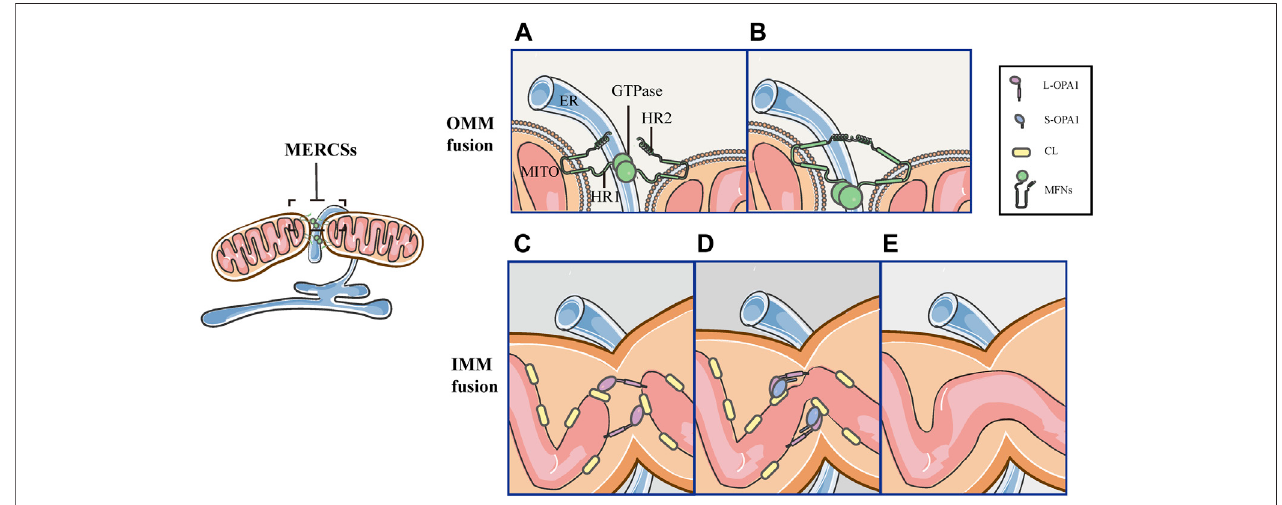
FIGURE6| SchematicdiagramsofmitochondrialfusionatMERCSs.MERCSsde fi nethepositionoftheOMMandIMMfusion,bothofwhicharecoordinatedatthe nodesofMERCSs.Mitochondrialfusionconsistsof fi vedistinctsteps. (A) OMMtethering:MFNstethertheOMMoftwoopposingmitochondriathroughtheirinteractions in trans of the HR2 and/or GTPase domains. (B) OMM docking: GTP hydrolysis induces conformational changes in MFNs, which trigger docking of the OMM. Subsequently, the GTPase-dependent MFNs oligomerization completes fusion of the OMM. (C) L-OPA1-CL tethering: the IMM fusion begins with the interaction betweenL-OPA1andCL. (D,E) IMMfusion:theL-OPA1-CLinteractionisenhancedbyS-OPA1,andtheOPA1-dependent